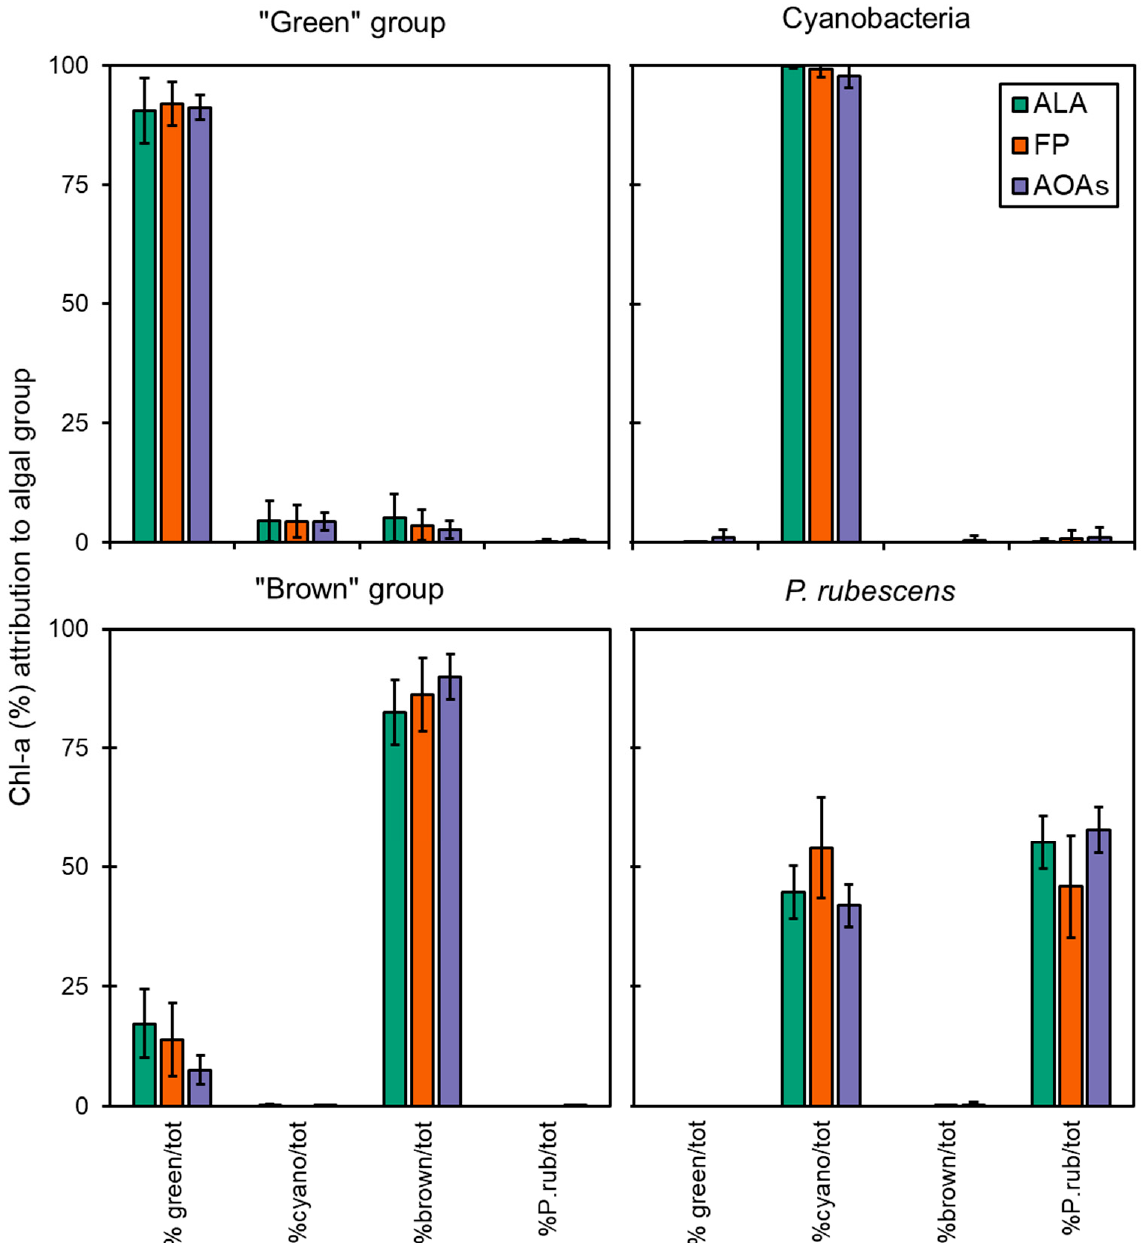
Figure 2. Chl- a concentration measured by the multi-wavelength spectrofluorometers (ALA, FP, and the four AOAs) on monoalgal cultures during intercalibration tests. Data reported are expressed as mean of the attribution percentage to four target algal groups with respect to the total Chl- a detected. %green/tot = percentage of Chl- a attributed to the “green” group; %cyano/tot = percentage of Chl- a attributed to Cyanobacteria; %brown/tot = percentage of Chl- a attributed to the “brown” group; %P.rub/tot = percentage of Chl- a attributed to P. rubescens .